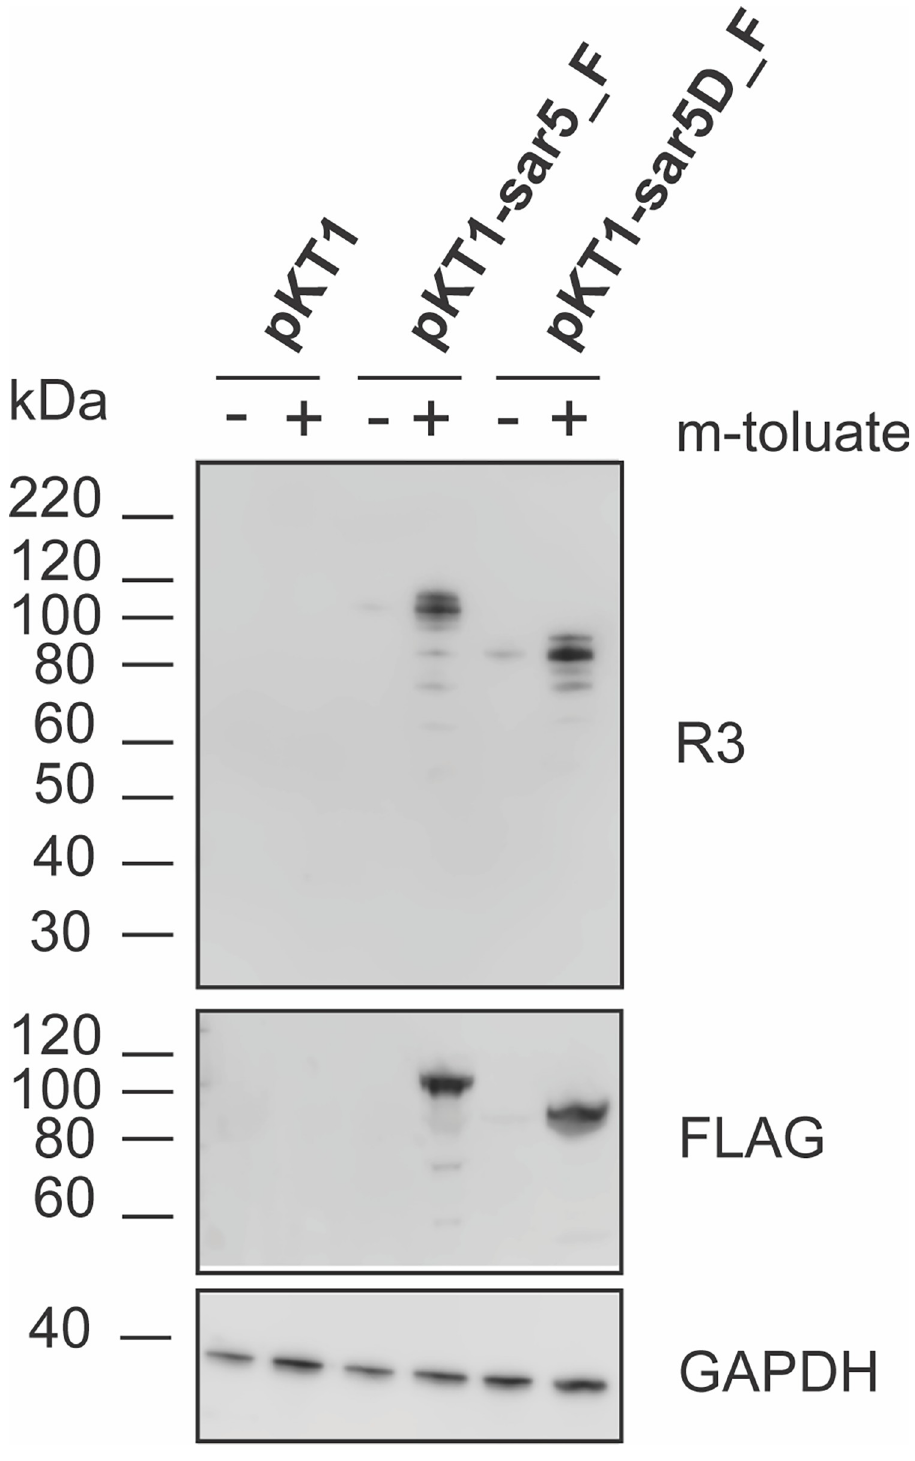
Fig 4. Western blot analysis of whole cell lysates from E. coli BL21 (DE3) carrying pKT1, pKT1-sar5-F or pKT1-sar5D-F plasmids, induced with 2 mM m-toluate (+) or mock-induced with the equivalent amount of the solvent ethanol (-). The blots were probed with r α -R3 antibody (upper panel), α -FLAG antibody (middle panel), or α -GAPDH antibody (lower panel). The protein standards are shown to the left of the blots. Raw data images of western blots are found in S1 Raw